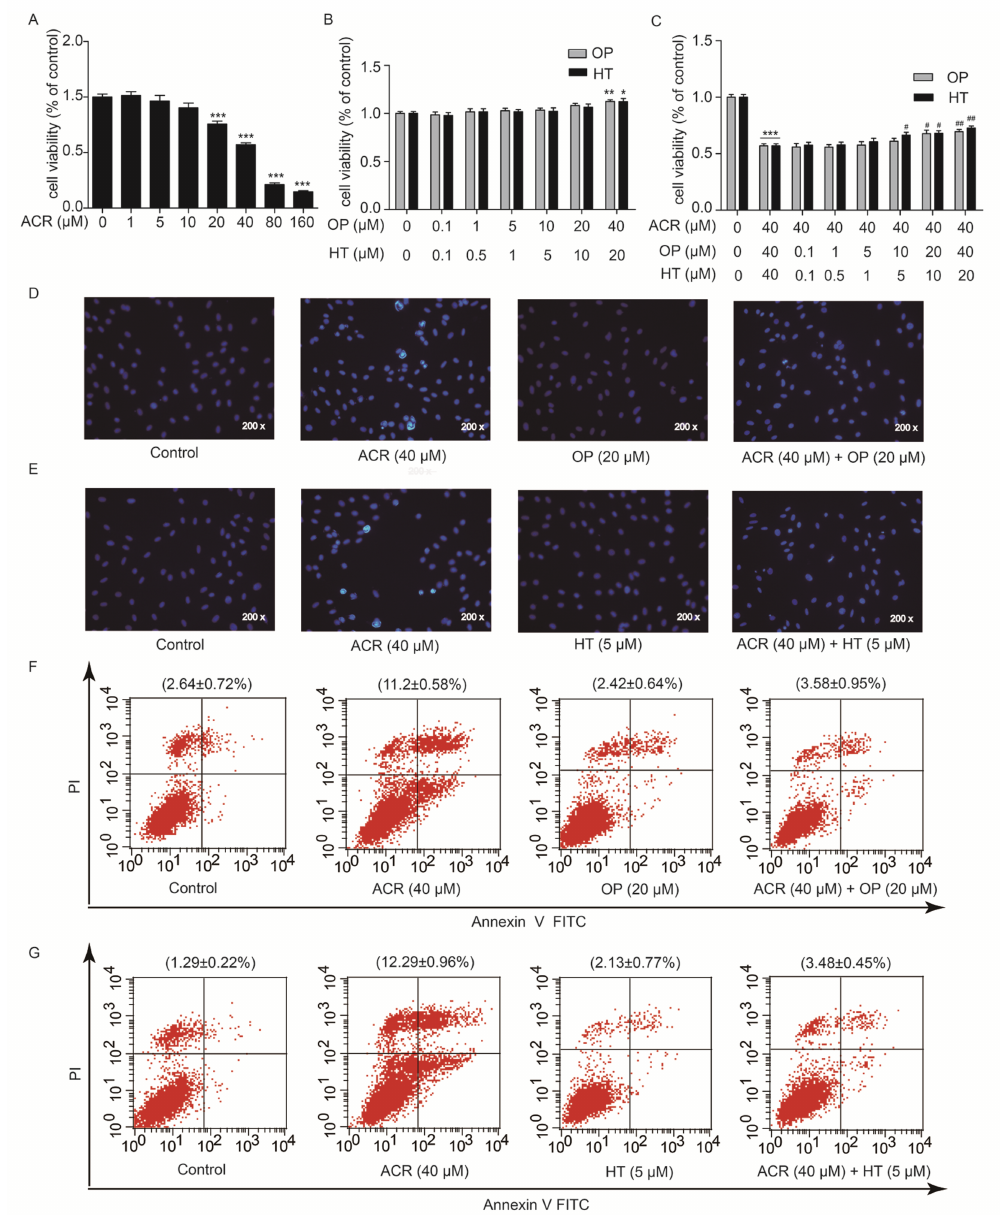
Figure 4. Hydroxytyrosol (HT) and OP reversed the H9c2 cells apoptosis induced by acrolein. ( A ) The cell viability of H9c2 after being treated with acrolein (0, 1, 5, 10, 20, 40, 80, 160 µ M) for 12 h, as measured by MTT assay; ( B ) The cell viability of H9c2 after treatment with HT (0, 0.1, 0.5, 1, 5, 10, 20 µ M) or OP (0, 0.1, 1, 5, 10, 20, 40 µ M) for 24 h, as measured by MTT assay; ( C ) The cell viability of H9c2 after pretreatment with HT (0, 0.1, 0.5, 1, 5, 10, 20 µ M) or OP (0, 0.1, 1, 5, 10, 20, 40 µ M) for 24 h, and combination with acrolein (40 µ M) for another 12 h, as measured by MTT assay; ( D – G ) the apoptosis rate of H9c2 after pretreatment with HT (5 µ M) and OP (20 µ M) for 24 h, and the combination with acrolein (40 µ M) for another 12 h, as detected by Hochest 33258 staining (original magnification is 200 × ) and Annexin-V FITC/PI staining flow cytometry. Statistical differences to the controls were shown as * p < 0.05, ** p < 0.01 and *** p < 0.001. Statistical differences to the grouptreated with acrolein (40 µ M) solely were shown as # p < 0.05 and ## p <